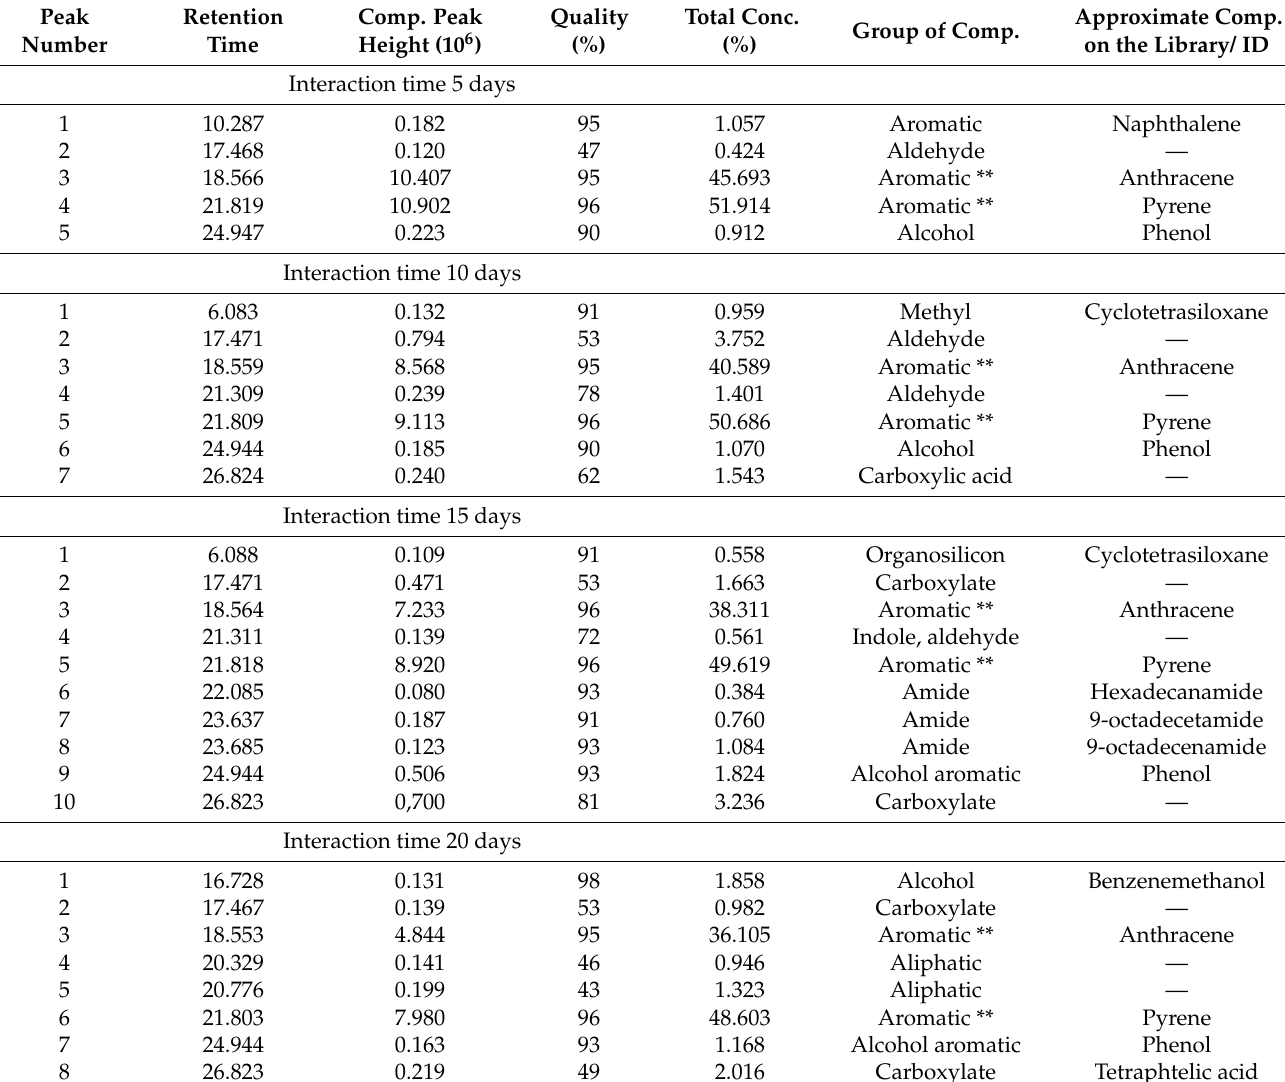
Table 5. GC–MS data on biodegradation of PAHs by a consortium of marine sponge bacterial